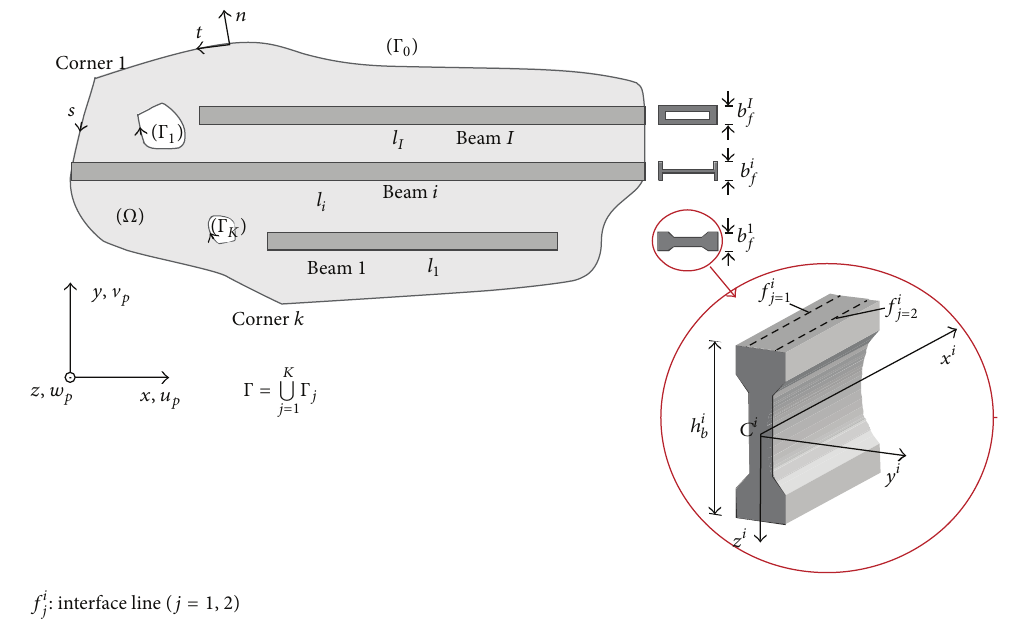
Figure 1: Two-dimensional region Ω occupied by the